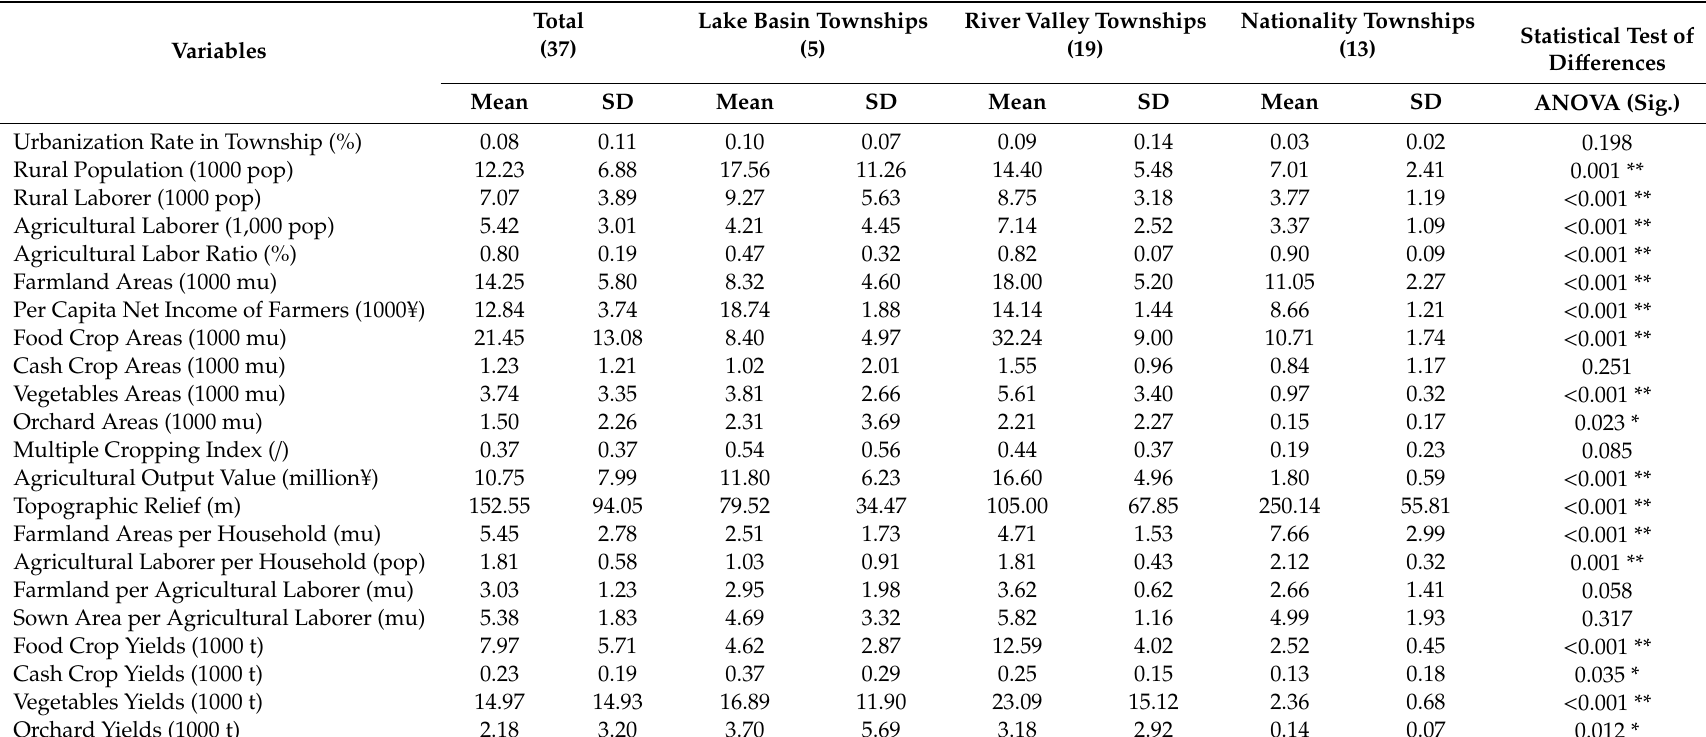
Table 1. Selection of variables for rural migration and agricultural structure and their summary statistics